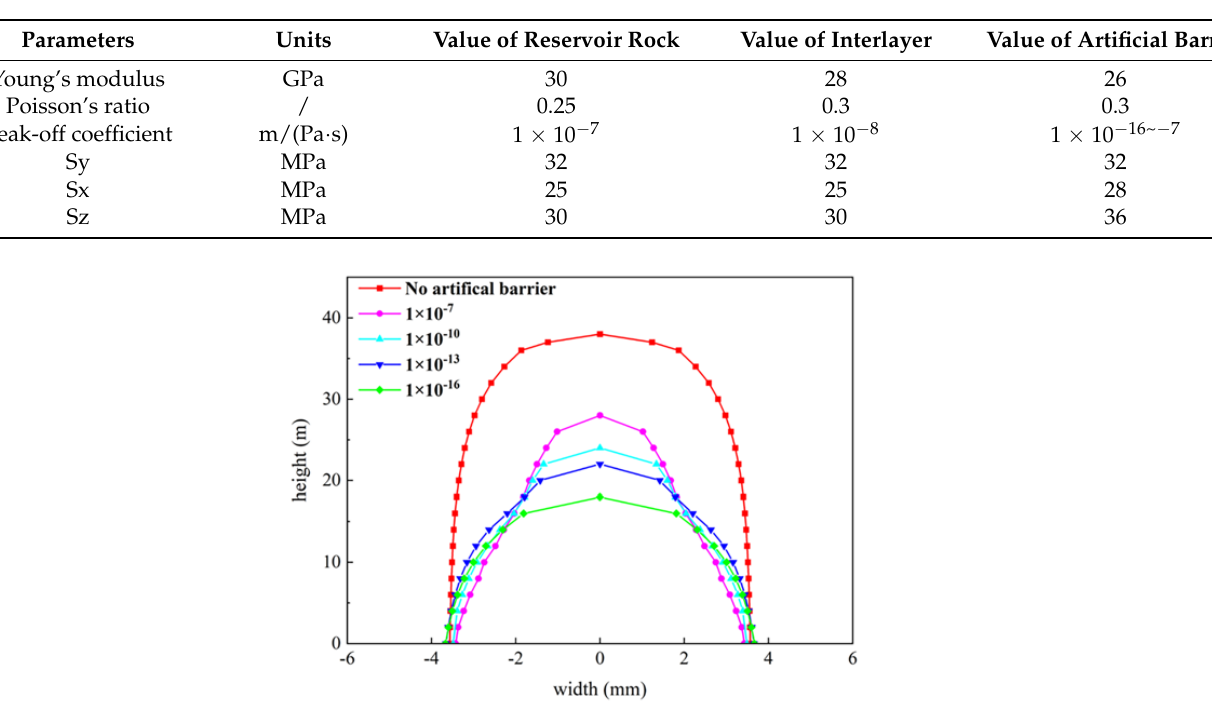
Table 3. The rock mechanics parameters of the stratum.